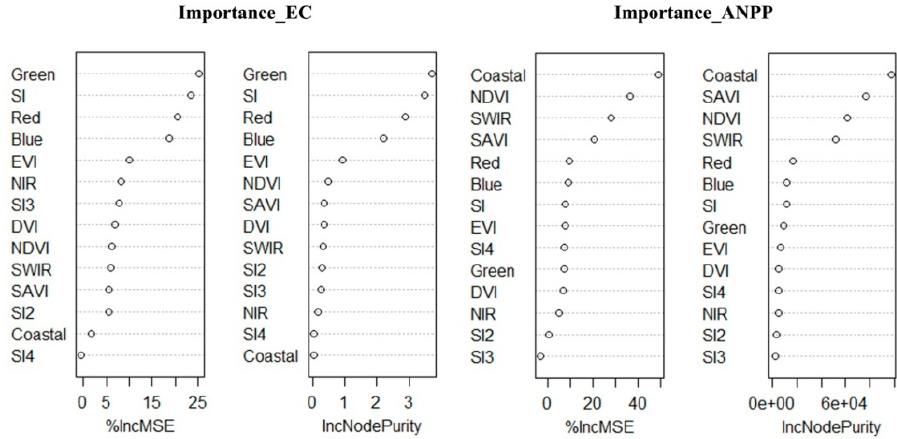
Figure 5. The importance score of variables for estimating aboveground net primary production (ANPP) and electrical conductivity (EC). The higher the importance scores the more important the variable for estimating ANPP and EC. SWIR is Shortwave Infrared; NIR is Near Infrared.